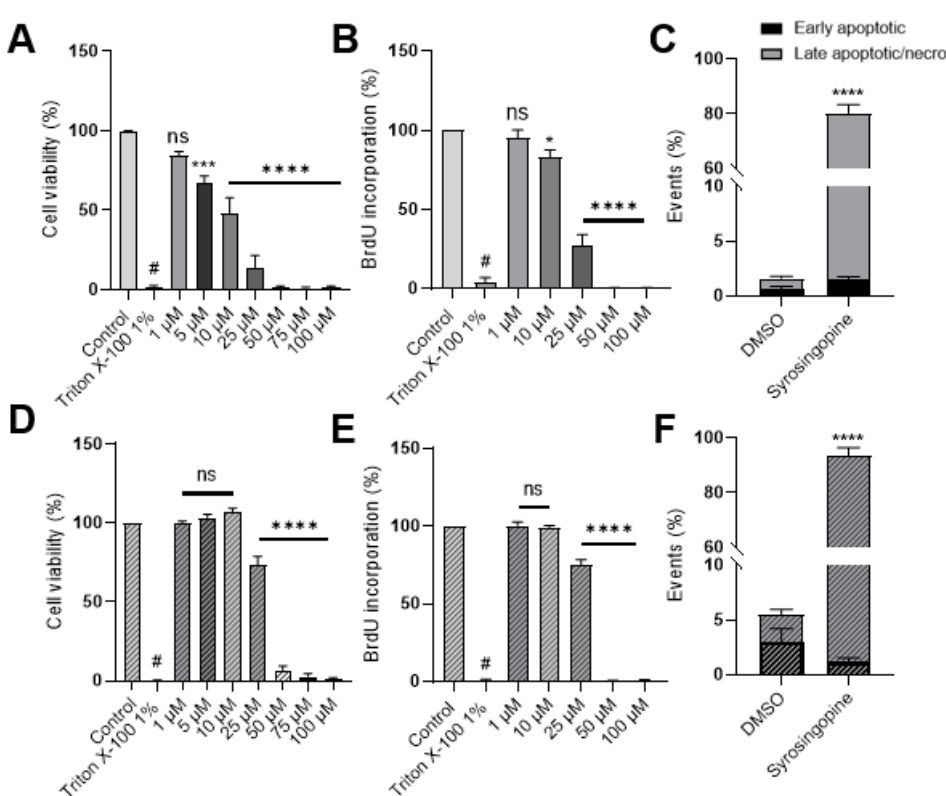
Figure 4. Impact of syrosingopine on tumor cell viability and proliferation. MDA-MB-231 (top, A – C ) and FaDu (bottom, D – F ) cells were treated with syrosingopine for 24, 48 and 72 h. Cell viability ( A , D ) and proliferation ( B , E ) are represented after 72 h of treatment. Percentages of early apoptotic/necrotic cells were calculated after treatment with 25 µ M of syrosingopine for 72 h ( C , F ). Data are represented as mean ± SEM of at least three independent experiments. Significance was determined using one-way or two-way ANOVA: * p < 0.05; *** p < 0.001; # = **** p < 0.0001. ns = not